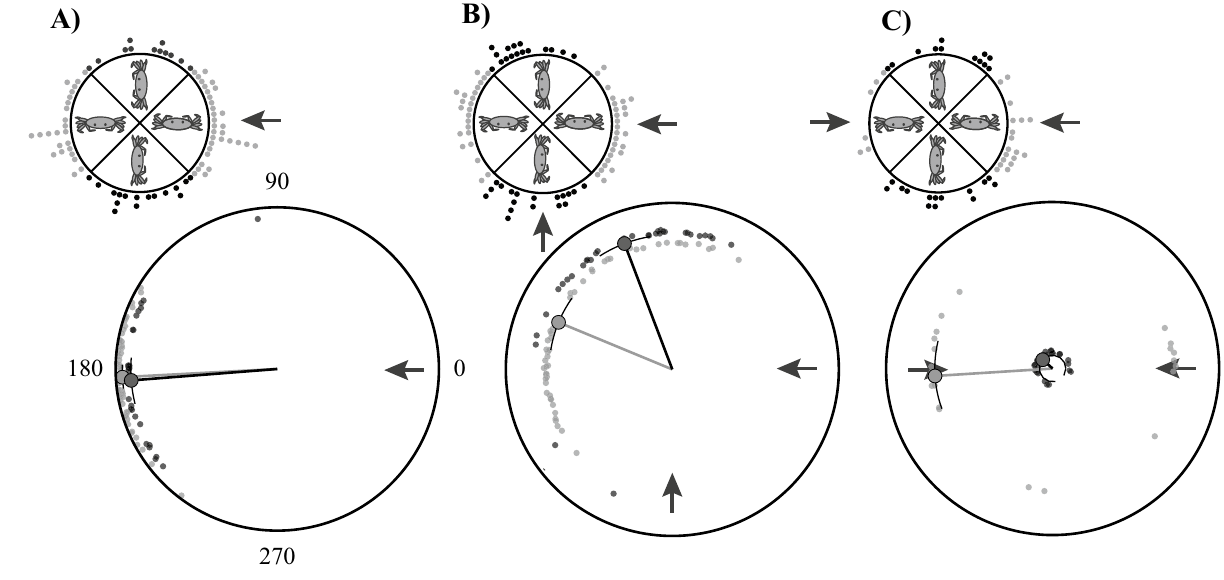
Figure 4. Escape direction of fiddler crabs as a function of their body orientation. ( A ) In response to a single stimulus, the crabs always ran directly away from the stimulus, irrespective of whether the stimulus approached the crabs laterally (grey) or along their posterior-anterior axis (black). ( B ) When the crabs faced the Paired 90 stimuli, they directed their escape run significantly more often away from the stimulus that aligned with their lateral body axes. Grey dots indicate runs where the 0° predator aligns with the crabs’ lateral axis and black dots runs where the predator at 270° aligns with the crabs’ lateral axis. ( C ) When confronted with the Paired 180 treatment, where the stimuli approach from either side (grey dots), there was no difference in mean escape direction, but when the stimuli aligned with the crabs’ posterior-anterior body axis (black dots), there was no directionality in the crabs escape response. The circular means and the uncertainty interval were calculated on transformed data (see Supplementary Material Table S4 for data transformation) but the data (small dots) are untransformed. Plot insets display the crabs’ initial body orientation relative to predator approach direction (black arrow). Each dot represents one observation, as either the orientation of the crab at the start of the escape (insets) or the escape direction (main plots). Data was binned in 90° angular sectors. Circular plots show the estimate of the circular mean (large dots) and 95% highest posterior density uncertainty intervals (UI, black curves). The length of the line segment that connects the circular mean to the plot centre indicates the mean resultant length